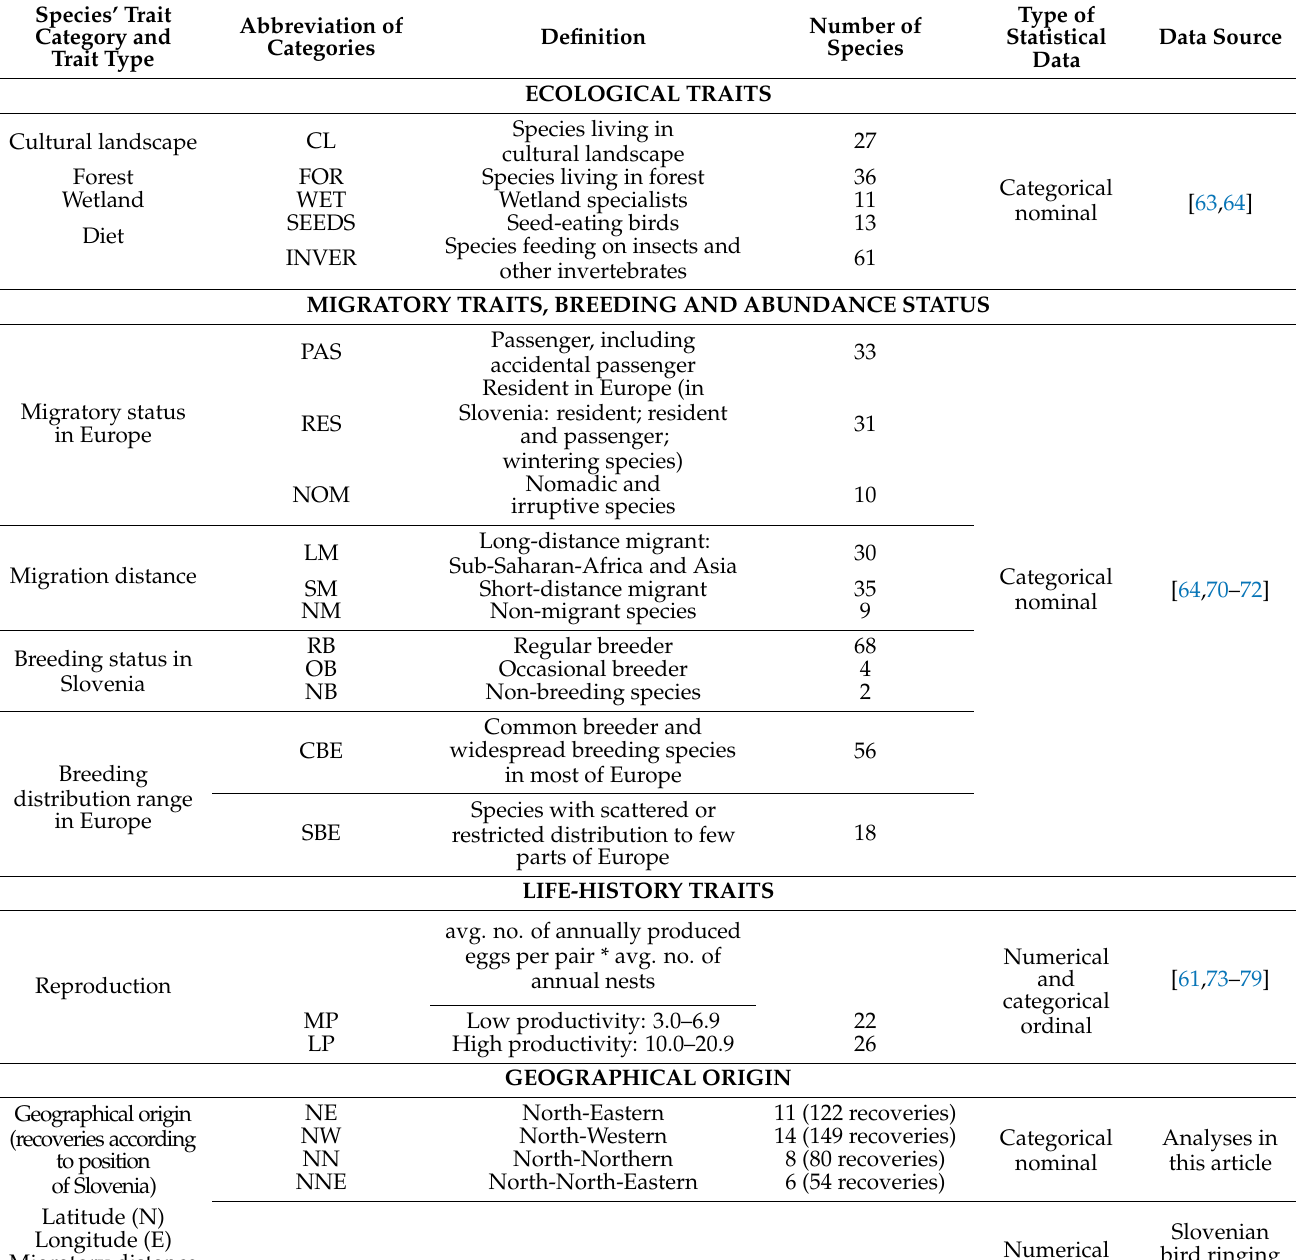
Table 1. Abbreviations of traits with given species number in each trait group, statistical type of data and data